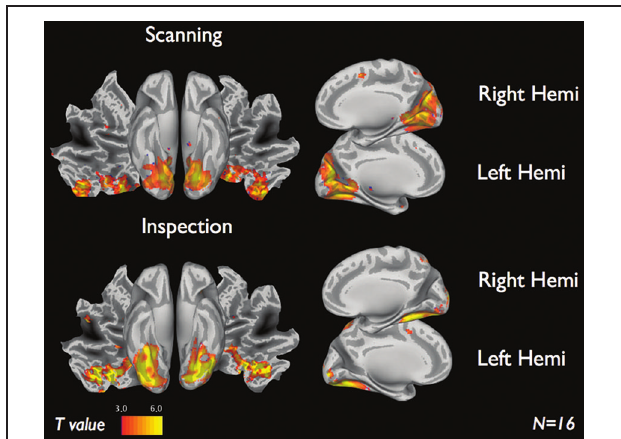
FIGURE 4 | fMRI results of each viewing mode vs. baseline for 16 subjects . Scanning (short fixations followed by large saccades) indicate visual regions near the cuneus. Inspection (long fixations followed by small saccades) indicate brain activity along the ventral stream. Results display T-maps, thresholded with a value of T > 3.